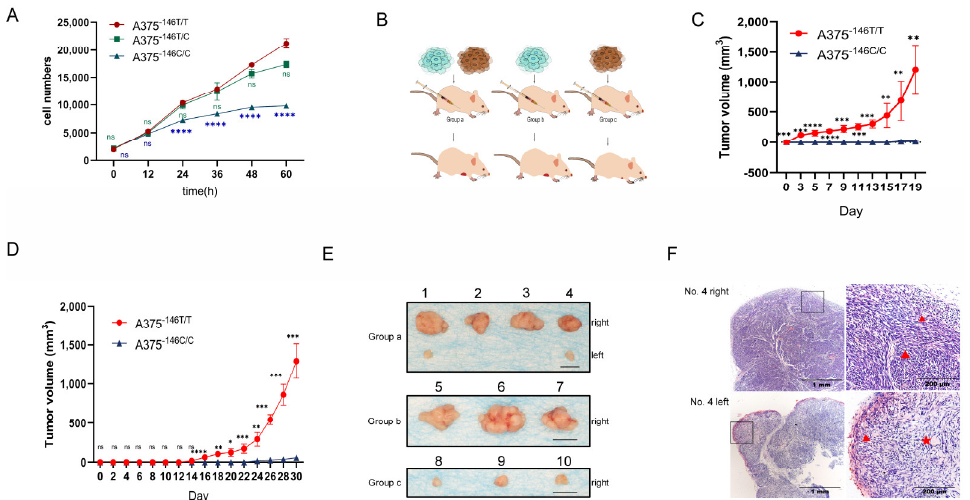
Figure 4. TERT -146 T>C inhibits melanoma growth. ( A ) Growth of A375 − 146T/T and A375 − 146T/C and A375 − 146C/C in vitro. These cells were plated and counted at the indicated time points; ( B ) cell-derived xenografts of A375 − 146T/T or A375 − 146C/C cells in nude mice. Nude mice were divided into three groups, and A375 − 146C/C or A375 − 146T/T was injected into the anterior ventral side of each nude mouse as described schematically. Group a, n = 4; right: A375 − 146T/T , left: A375 − 146C/C . Group b and c, n = 6; group b right: A375 − 146T/T . Group c right, A375 − 146C/C cells; ( C ) growth of A375 − 146T/T and A375 − 146C/C in nude mice of group a. After the third day of cell-derived xenografts in group a nude mice, the bilateral tumor size was measured at the indicated time points until the end of 19 days; ( D ) growth of A375 − 146T/T or A375 − 146C/C in nude mice of groups b and c. Tumor size was measured at the indicated time points until the end of 30 days; ( E ) typical tumors corresponding to 19 days and 30 days, respectively (scale bar, 1 cm); (Group a nude mice: No. 1, No. 2, No. 3,